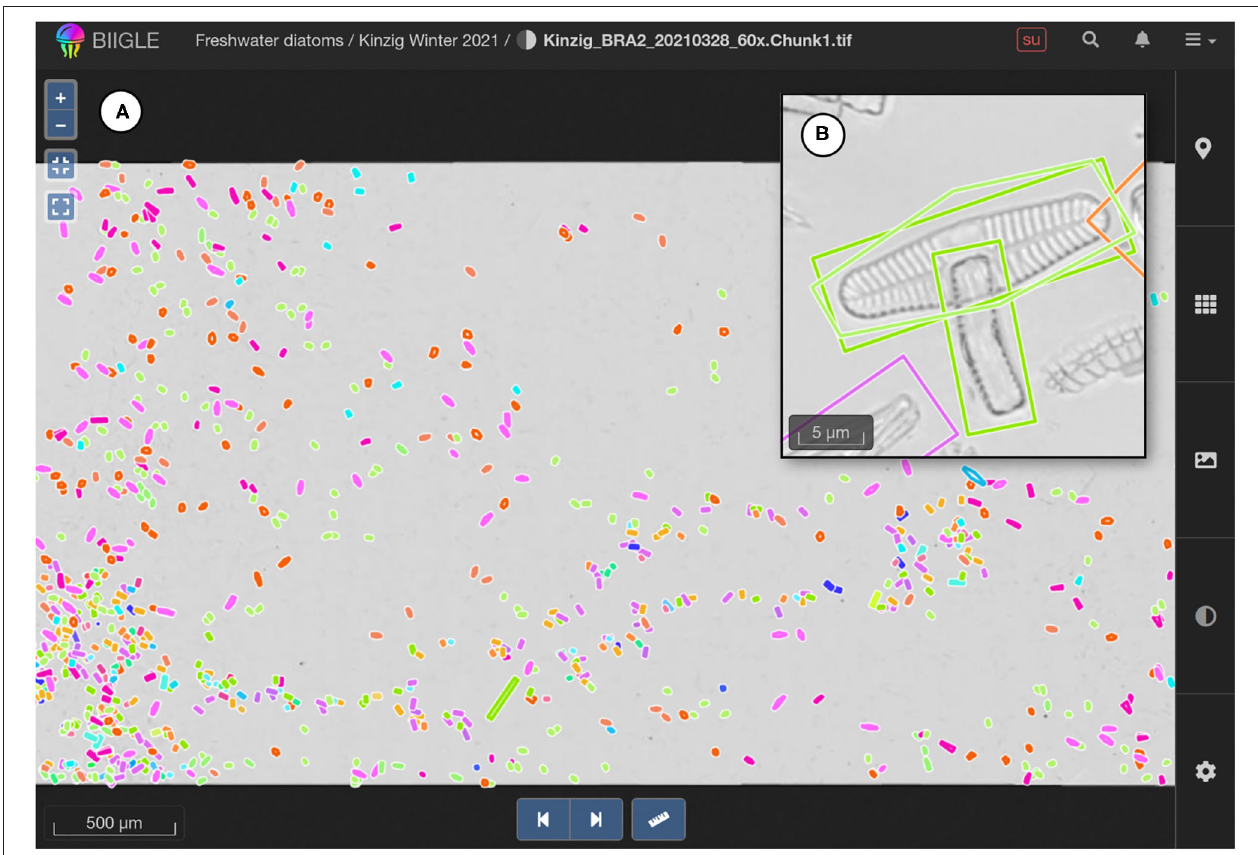
FIGURE 4 | Annotated gigapixel image (virtual microscopy slide, 55,354 × 28,112 px). (A) Overview of the full image in the image annotation tool of BIIGLE. (B) Crop of the image in the original resolution (not part of the user